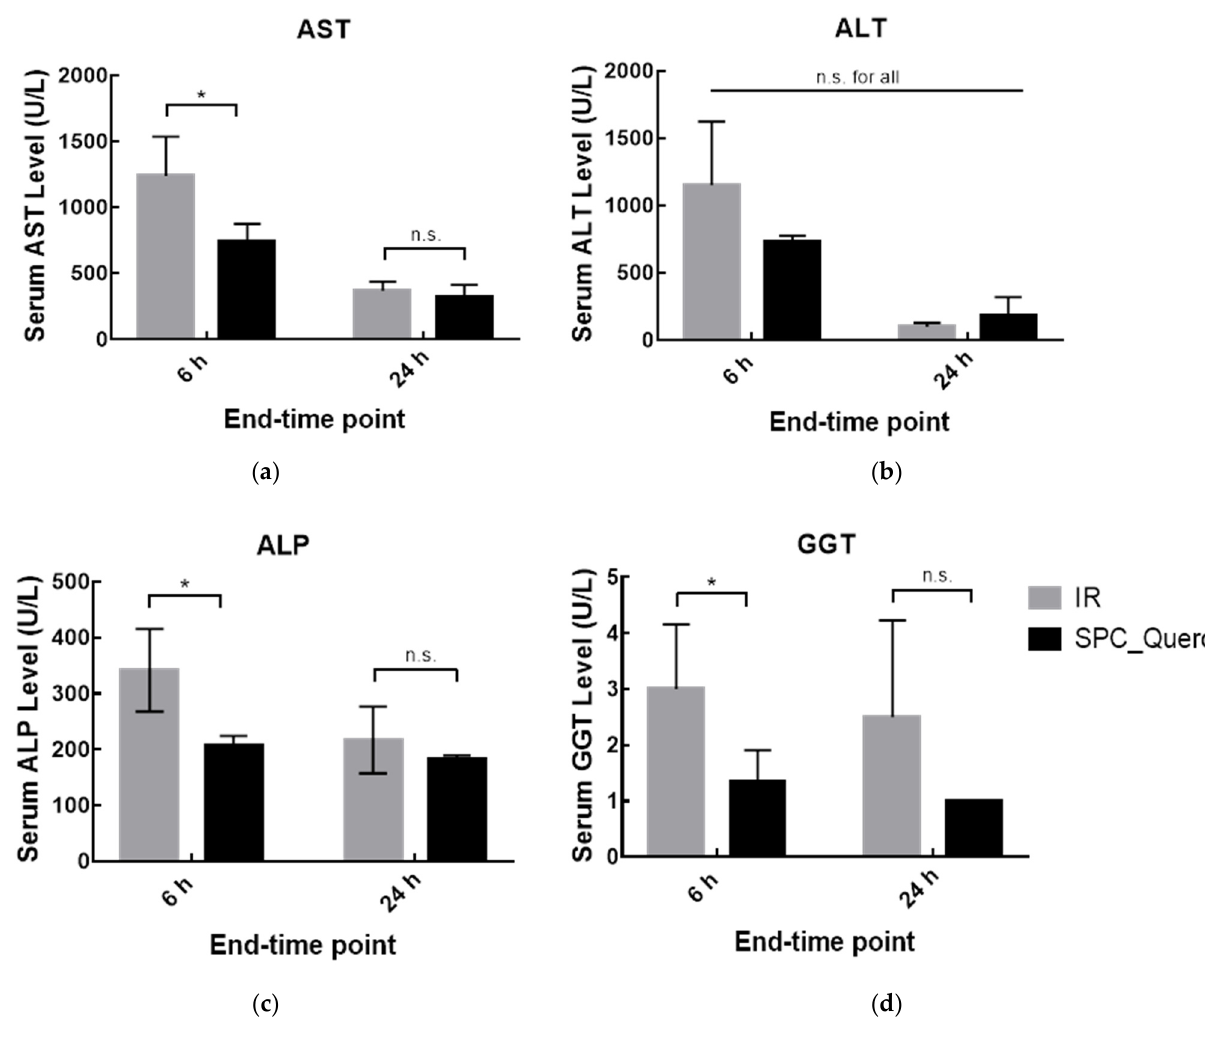
Figure 12. Serum AST ( a ), ALT ( b ), ALP ( c ), and GGT ( d ) levels in rats without treatment or treated with quercetin formulation. Rats were sacrificed 6 h or 24 h after the reperfusion onset. Results are presented as mean ± SD ( n = 4). * p < 0.05 compared with IR group of the correspondent end-time point. n.s., statistically non-significant compared with IR group of the correspondent end-time point.